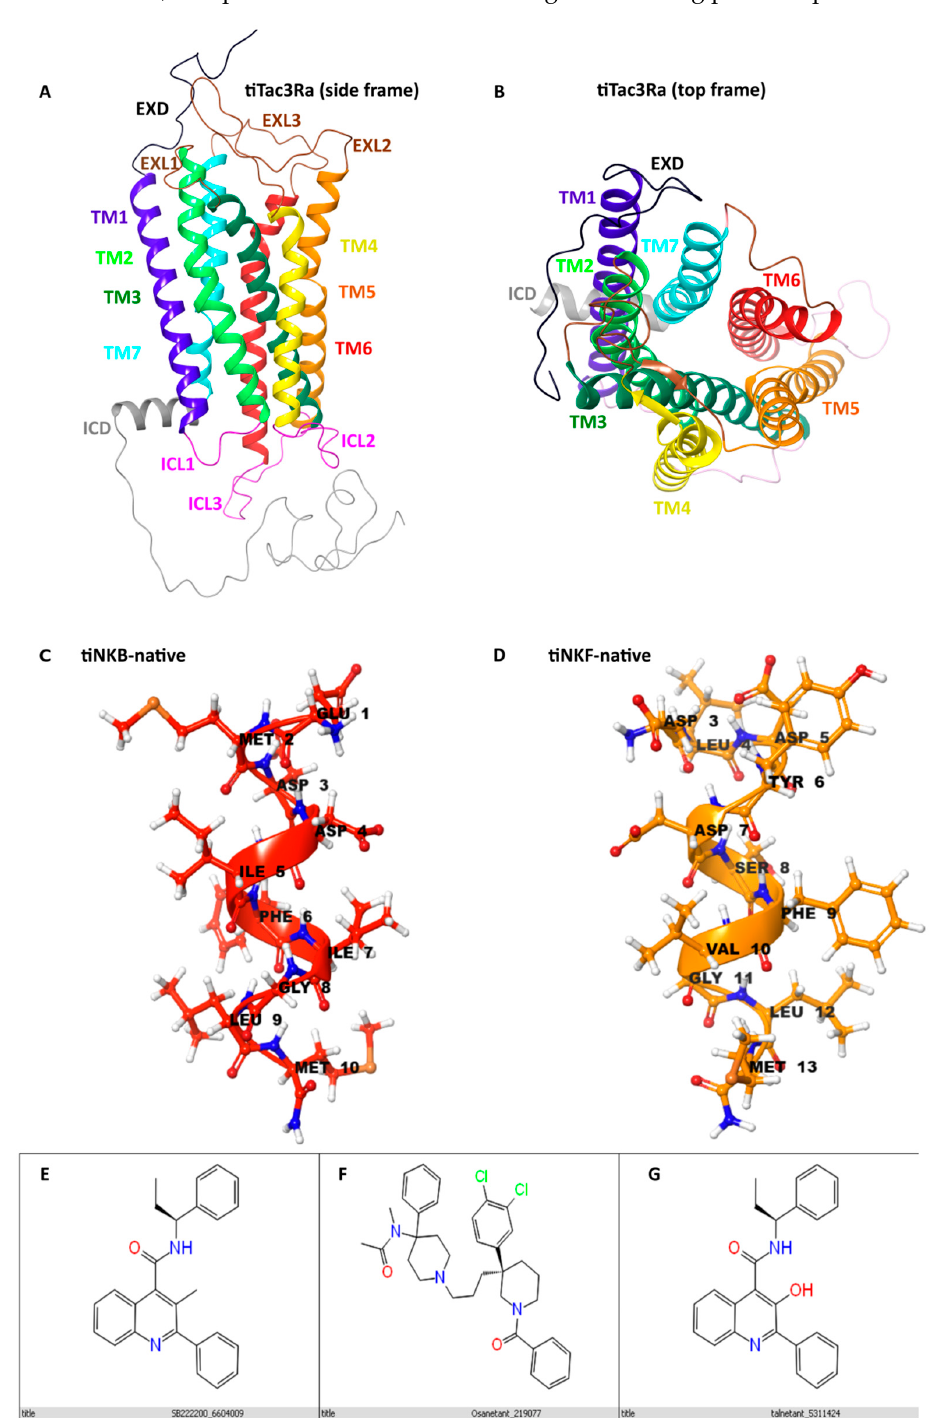
Figure 1. Homology models: Showing predicted homology models for tiTac3Ra, tiNKB & tiNKF and their antagonists ( A ); Side view of tiTac3Ra: extra cellular domain (EXD: Black); Intracellular domain (ICD:Grey); trans membrane domains (TM1: Purple; TM2:Green; TM3:Dark green; TM4:Yellow; TM5: Orange; TM6:Red; TM7:Cyan). Intracellular loops: Pink; Extra cellular loop: Brown. ( B ) Top view tiTac3Ra; ( C ) Native tiNKB; ( D ) Native tiNKF. NKB antagonists: ( E ) SB-222200; ( F ) Osanetant; ( G ) Talnetant.